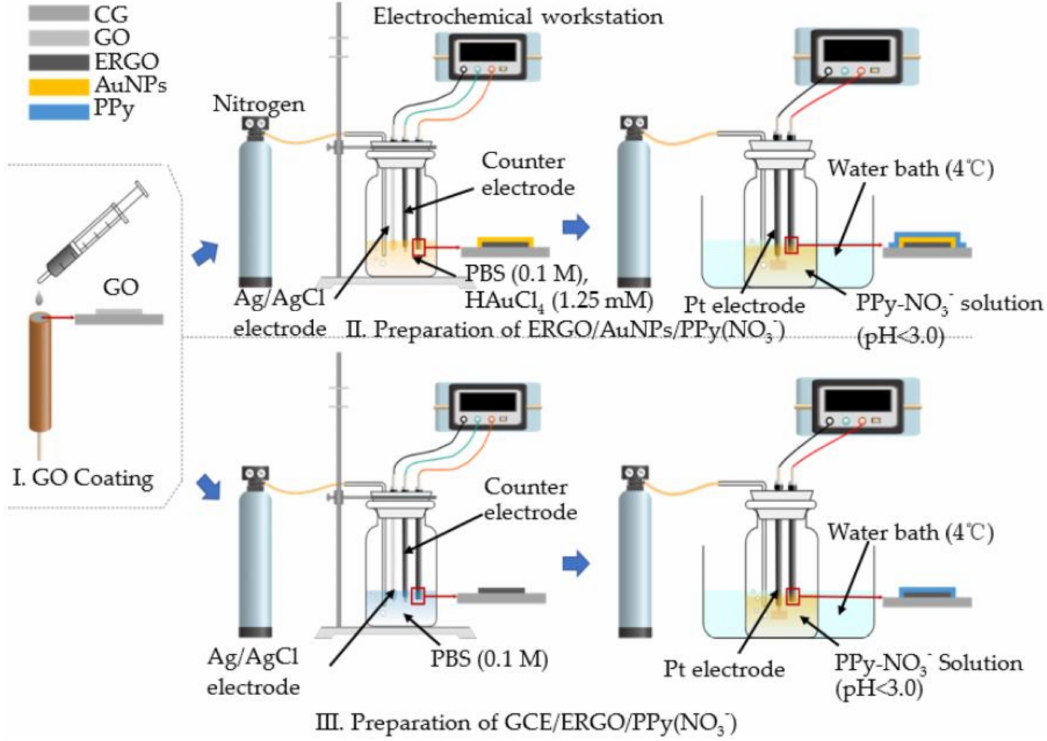
Fabrication diagram of all-solid-state ion-selective electrodes (ISEs) with mediate films of ERGO / AuNPs and electrochemically reduced graphene oxide (ERGO). Note: AuNPs are gold